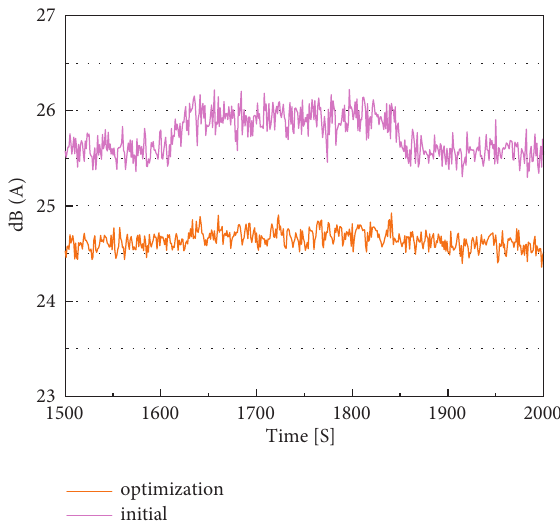
Figure 6: Time domain diagram of the noise of the capillary outlet before and after aeration.